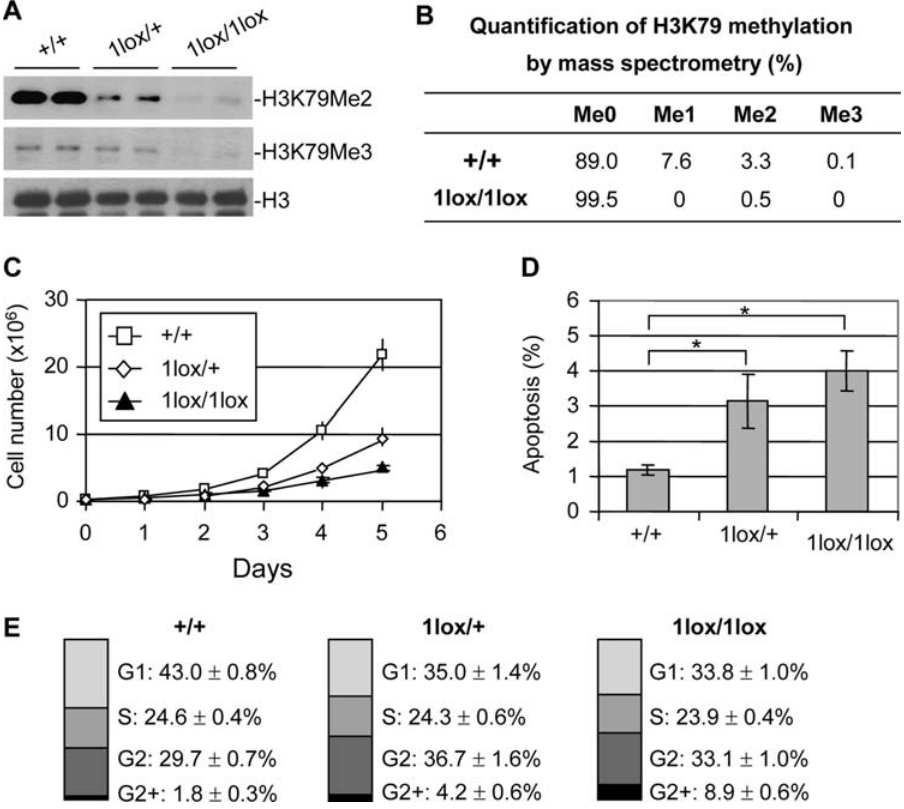
Figure 3. Phenotypic analysis of Dot1L mutant ES cells. (A) Western blot analysis using extracts from ES cell lines of the indicated Dot1L genotypes and antibodies specific for di-, and tri-methylated H3K79. Total histone H3 was used as a loading control. (B) Analysis of H3K79 methylation by mass spectrometry. Quantification of different forms of H3K79 methylation was obtained by comparing the extracted ion chromatogram (EIC) intensity of the ion signals corresponding to the unmodified (Me0), mono-methylated (Me1), di-methylated (Me2), and tri- methylated (Me3) K79-containing peptides. (C) The proliferation of Dot1L + / + , Dot1L 1lox/ + and Dot1L 1lox/1lox ES cells was determined by doing cell counts every 24 hours for five days. Cells were grown in triplicate, and data shown is representative of three independent experiments. (D) The percentages of apoptotic cells in Dot1L + / + , Dot1L 1lox/ + and Dot1L 1lox/1lox ES cell cultures. The asterisk indicates P , 0.05 (Student t-test). ES cells were stained with propidium iodide (PI) and PE conjugated anti-annexin V antibodies and analyzed by FACS. Apoptotic cells were annexin V positive and PI negative. Cells were grown in triplicate, and data shown are representative of two independent experiments. (E) The percentages of each cell cycle stage in Dot1L + / + , Dot1L 1lox/ + and Dot1L 1lox/1lox ES cell cultures as determined by PI staining and